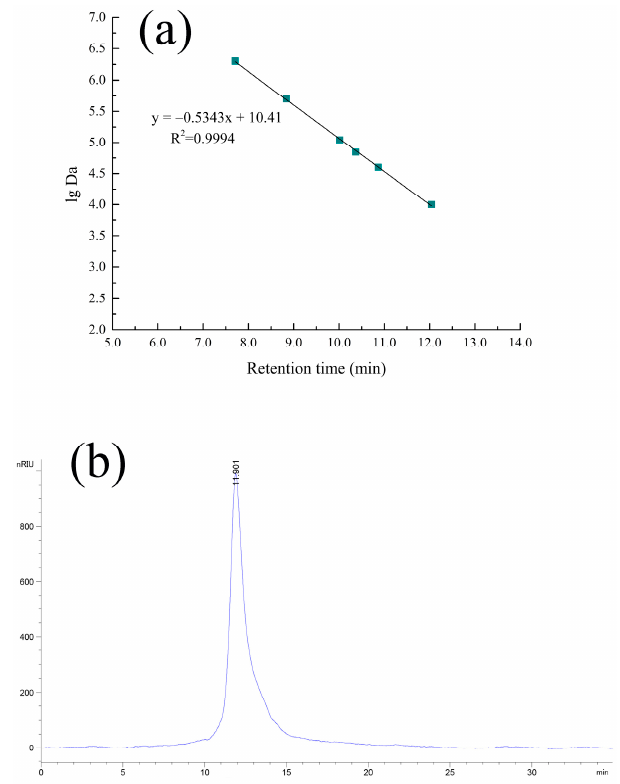
Figure 1. The standard curve ( a ) and results of HPGPC of cAMPs-1A ( b ).